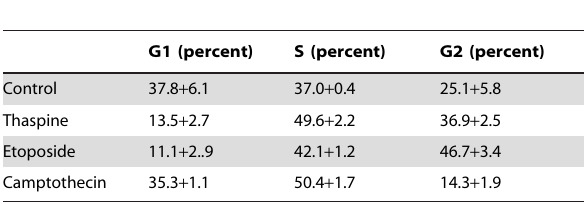
Table 3. Effects of thaspine and reference compounds on the HCT116 cell